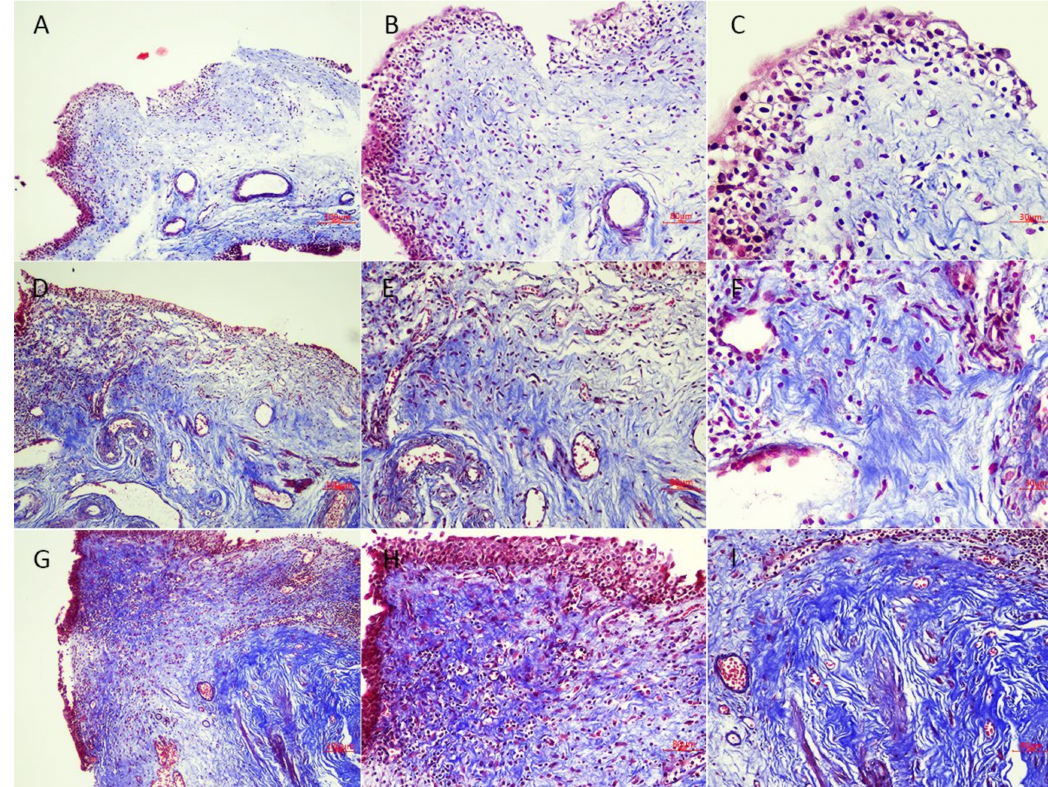
Figure 4. Bladder Masson’s trichrome staining characteristics in each computed tomography (CT) groups. ( A – C ) Patients with smooth bladder wall on CT. The specimens showed no obvious collagen accumulation in the bladder, only a few fine collagen fibers could be found. ( D – F ) The patients with focal bladder thickening. Obvious collagen deposition in the deep lamina propria was noted. ( G – I ) Patients with diffuse bladder thickening. Thick collagen fiber accumulated in both superficial and deep lamina propria. Scale bar = 100 µ m ( A , D , G ), 80 µ m ( B , E , H , I ), and 30 µ m ( C , F